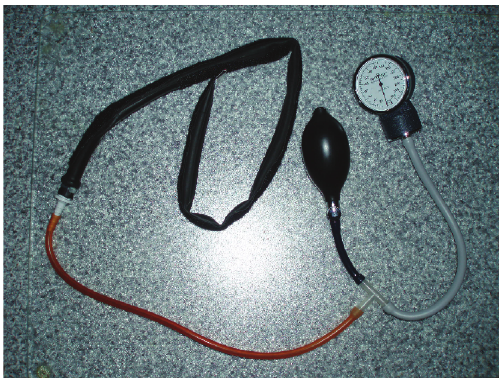
Figure 1: Artificial necktie apparatus.